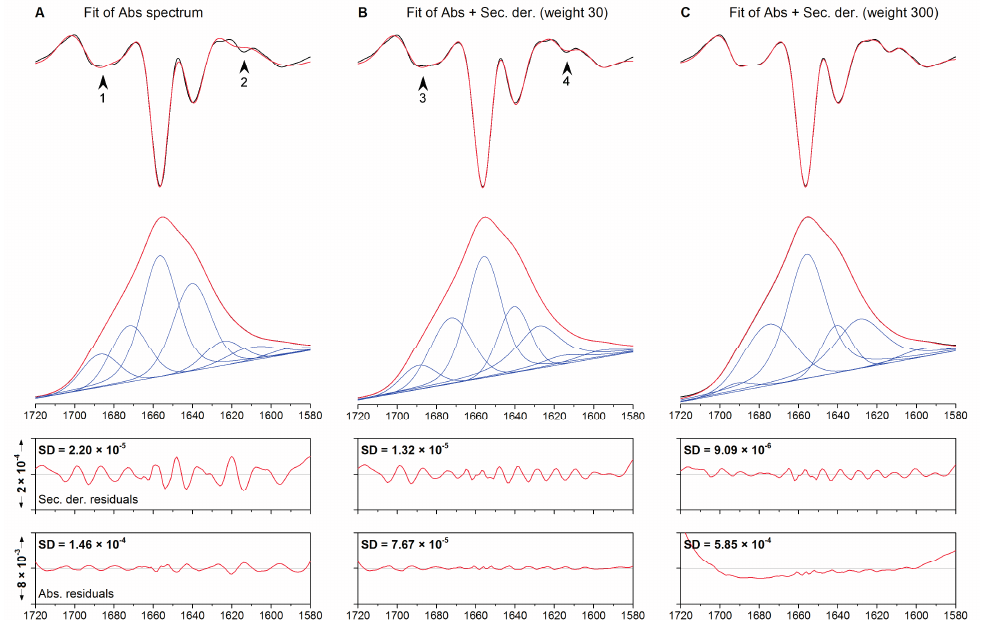
Figure 5. Fitting of the absorption spectrum of aconitase. ( A ) fitting of the absorption spectrum only; ( B , C ) simultaneous fitting of the absorption and second derivative spectra with weights of 30 and 300, respectively. From top to bottom: second derivative, absorption spectra and plots of the residuals. Original spectra are shown black, fitted spectra in red. The individual bands are shown in blue. Arrow heads denote noteworthy discrepancies between the experimental and fitted